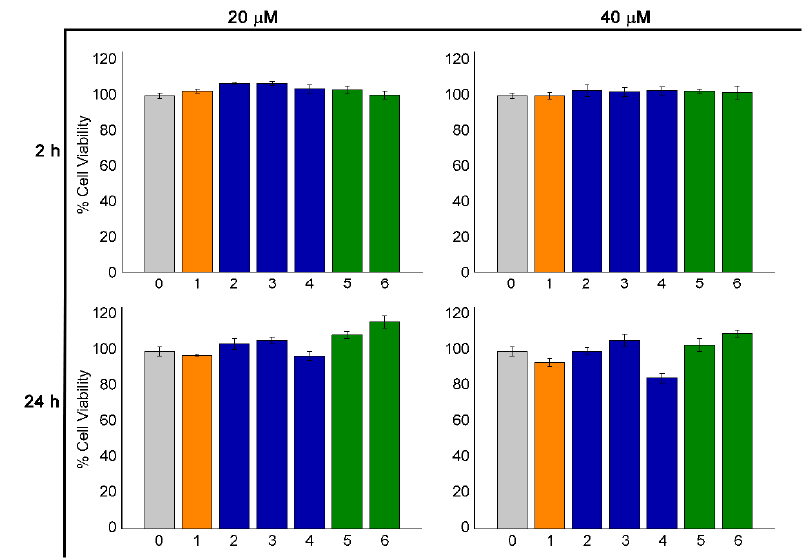
Figure 6. Cell viability after 2 and 24 h incubation with the iridium complexes at 20 and 40 µM. (0) Control (2% DMSO in Dulbecco's Modified Eagle medium): (1) [Ir( ppy ) 2 ( TzPyNH 2 )]; (2)